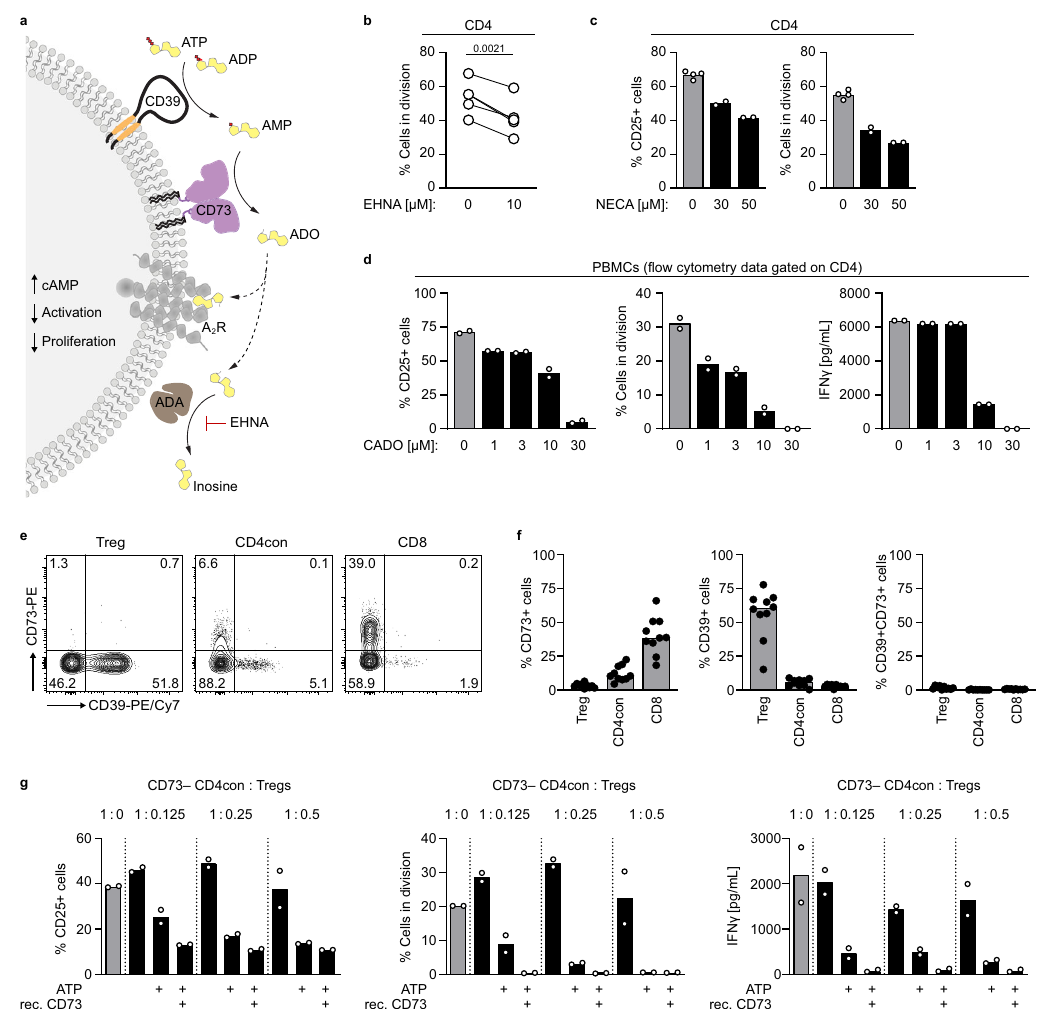
Fig. 1 Adenosine generated in the course of T cell activation prevents an exacerbated T cell response. a Schematic representation for the degradation of ATP to adenosine by the ectonucleotidases CD39 and CD73. b – d PBMCs or CD4 T cells were stimulated with α CD3/ α CD28 and treated with b the ADA inhibitor EHNA or different concentrations of adenosine receptor agonists c NECA, and d CADO. CD25 expression and proliferation were measured after 3 to 4 days by fl ow cytometry. Data were shown for b fi ve donors or c , d one representative donor (mean of technical replicates). e , f CD73 and CD39 expression on human T cell subsets in e representative dot plots and f as a summary for ten donors (median). g CD73 − CD4con T cells were stimulated with α CD3/ α CD28 in the presence of the ADA inhibitor EHNA (10 µ M) and incubated with Tregs, ATP (50 µ M) and recombinant CD73 (15 ng/mL) as indicated. The ratios of CD4con T cells to Tregs were 1:0.125 to 1:0.5. CD25 expression and proliferation were measured after 4 days by fl ow cytometry. IFN γ production was determined by ELISA in the cell culture supernatant on day 4. Data were shown for one representative donor out of four analyzed (mean of technical duplicates). A two-tailed paired t -test was used to compare untreated and treated samples in b